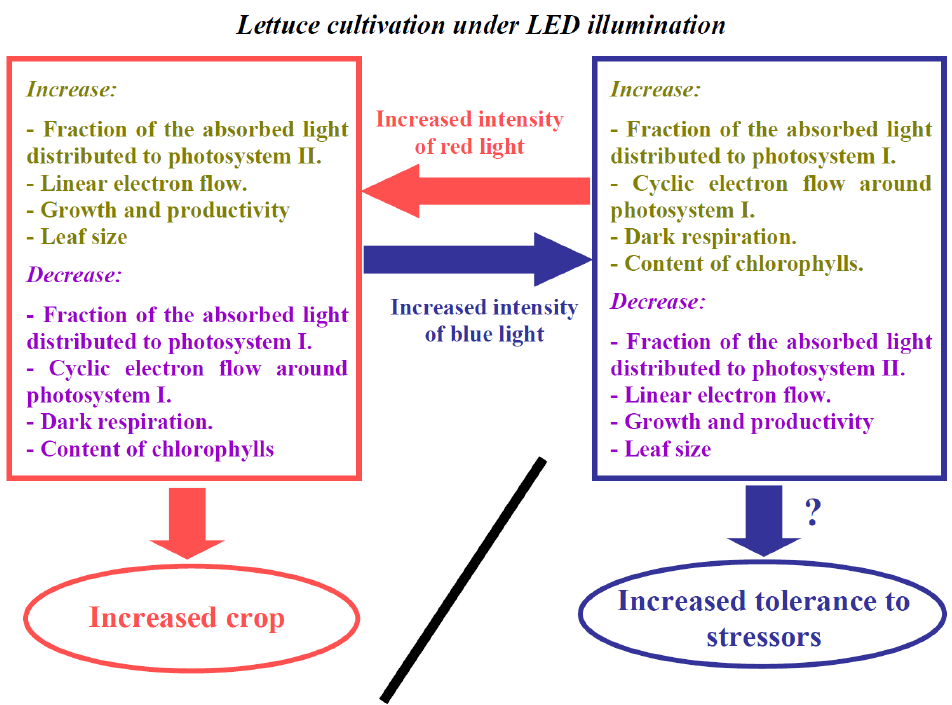
Figure 11. Proposed schema of changes in physiological and growth processes in lettuce during cultivation under the increased red light and blue light intensities.